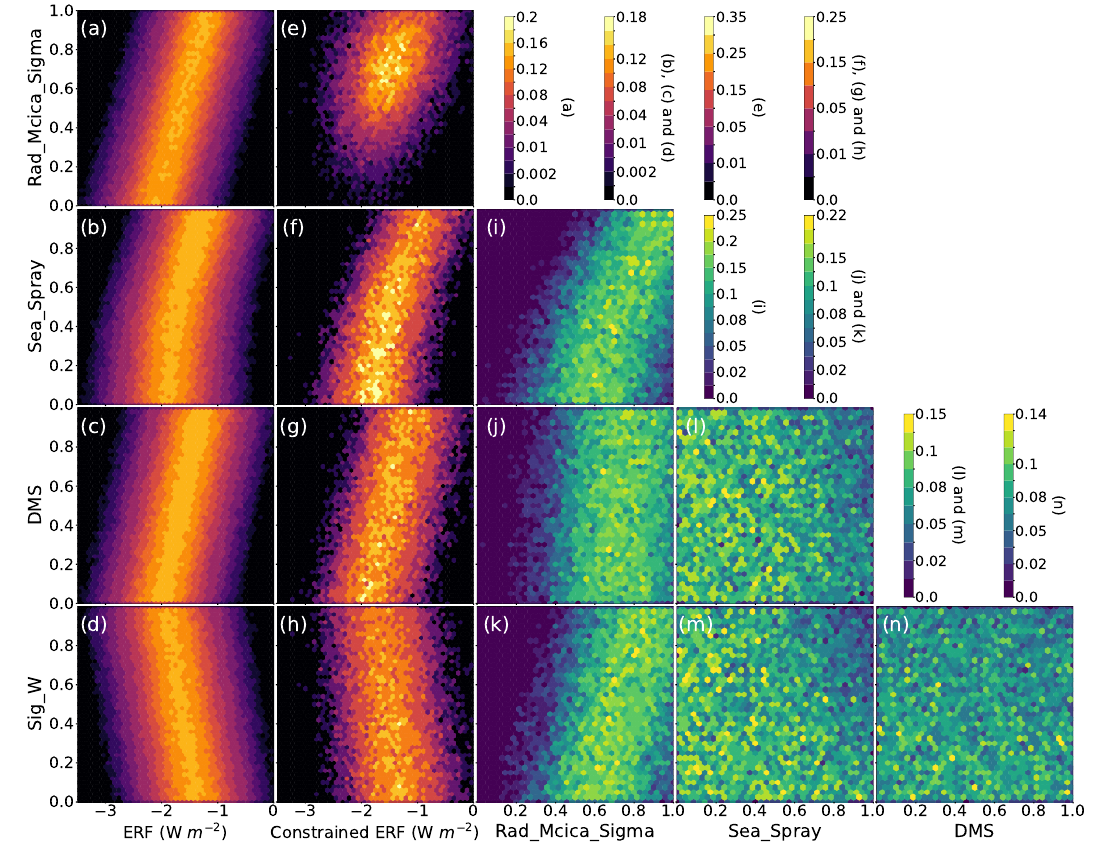
Figure 13. Probability density distributions of aerosol ERF and the parameters Rad_Mcica_Sigma, Sea_Spray, DMS and Sig_W in the unconstrained sample (first column, a – d ) and in the sample constrained to match the observed global annual mean RSR (second column, e – h ). Probability density distributions of parameter values are shown for the constrained sample ( i – n ). Colour bars labelled a–n correspond with the sub-figures and show the percentage of each sample within each pixel. Some colour bars apply to multiple